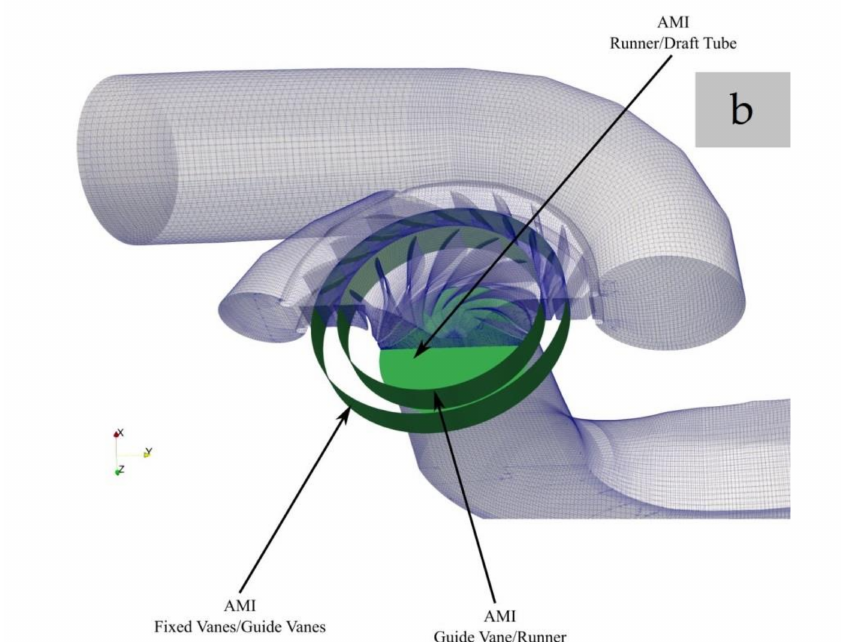
Figure 1. ( a ) Grid mesh for a Francis turbine; ( b ) AMI interfaces.